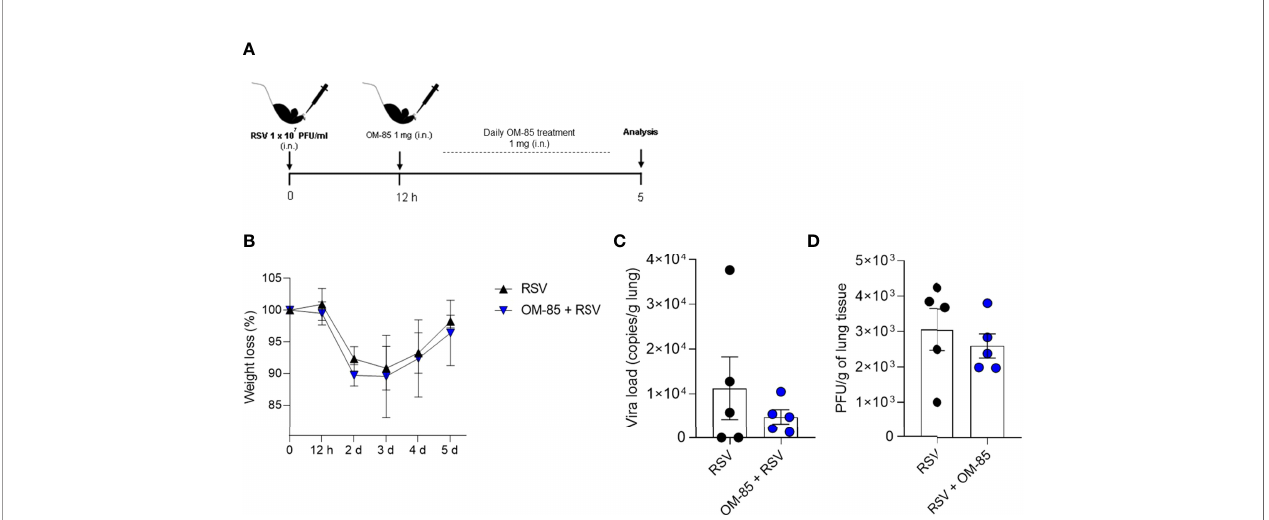
FIGURE 1 | Therapeutic treatment with OM – 85 does not modulate antiviral response against RSV infection. Mice were infected intranasally with RSV (1x10 7 PFU/ml) and 12 hours later started to receive intranasal administration of OM – 85 (1mg). Treatment persisted daily until 5 days post infection. (A) Experimental design. (B) Percentage of weight loss relative to day 0 (right before infection). (C) RSV viral load detected in lung tissue by real – time PCR (viral copies/g of lung tissue). (D) Viral titer in the lung (PFUs/g lung tissue). Data from one independent experiment (n = 6 per group). All data are expressed as mean±SEM. Statistical signi fi cance between groups was determined by Mann – Whitney. A p value<0.05 was considered signi fi